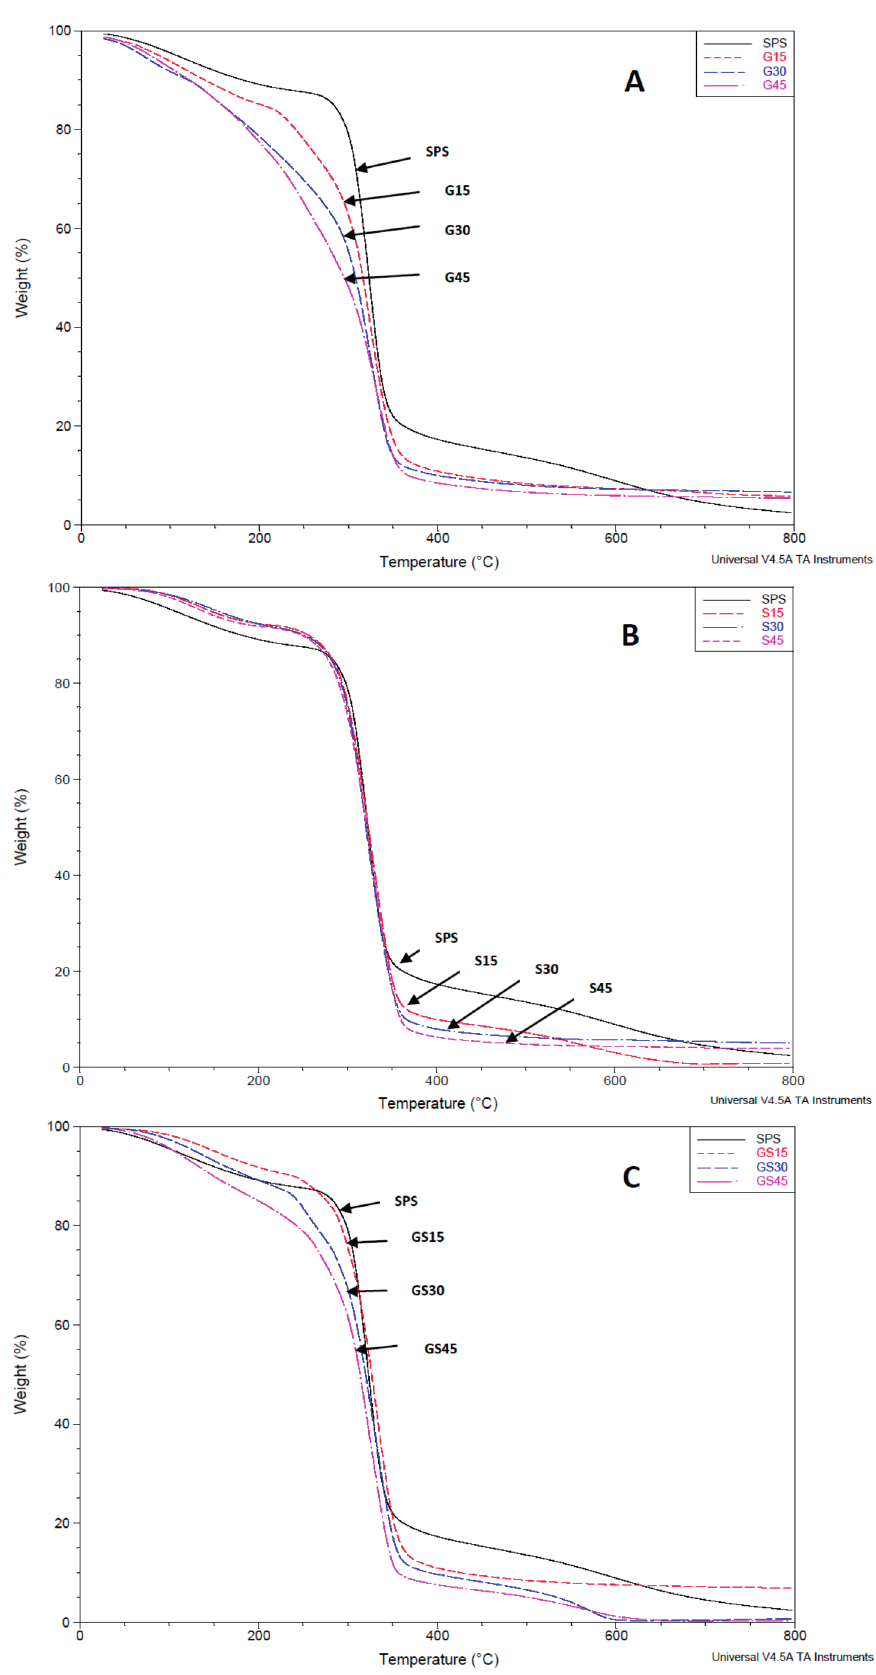
Figure 4. TGA curves of G-plasticized ( A ); S-plasticized ( B ); and GS-plasticized films ( C ) at different concentrations (15%, 30%, and 45%) compared to unplasticized SPS